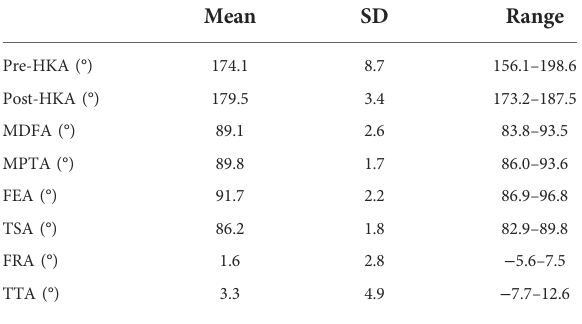
TABLE 1 Measurement results of post-operative joint alignment.